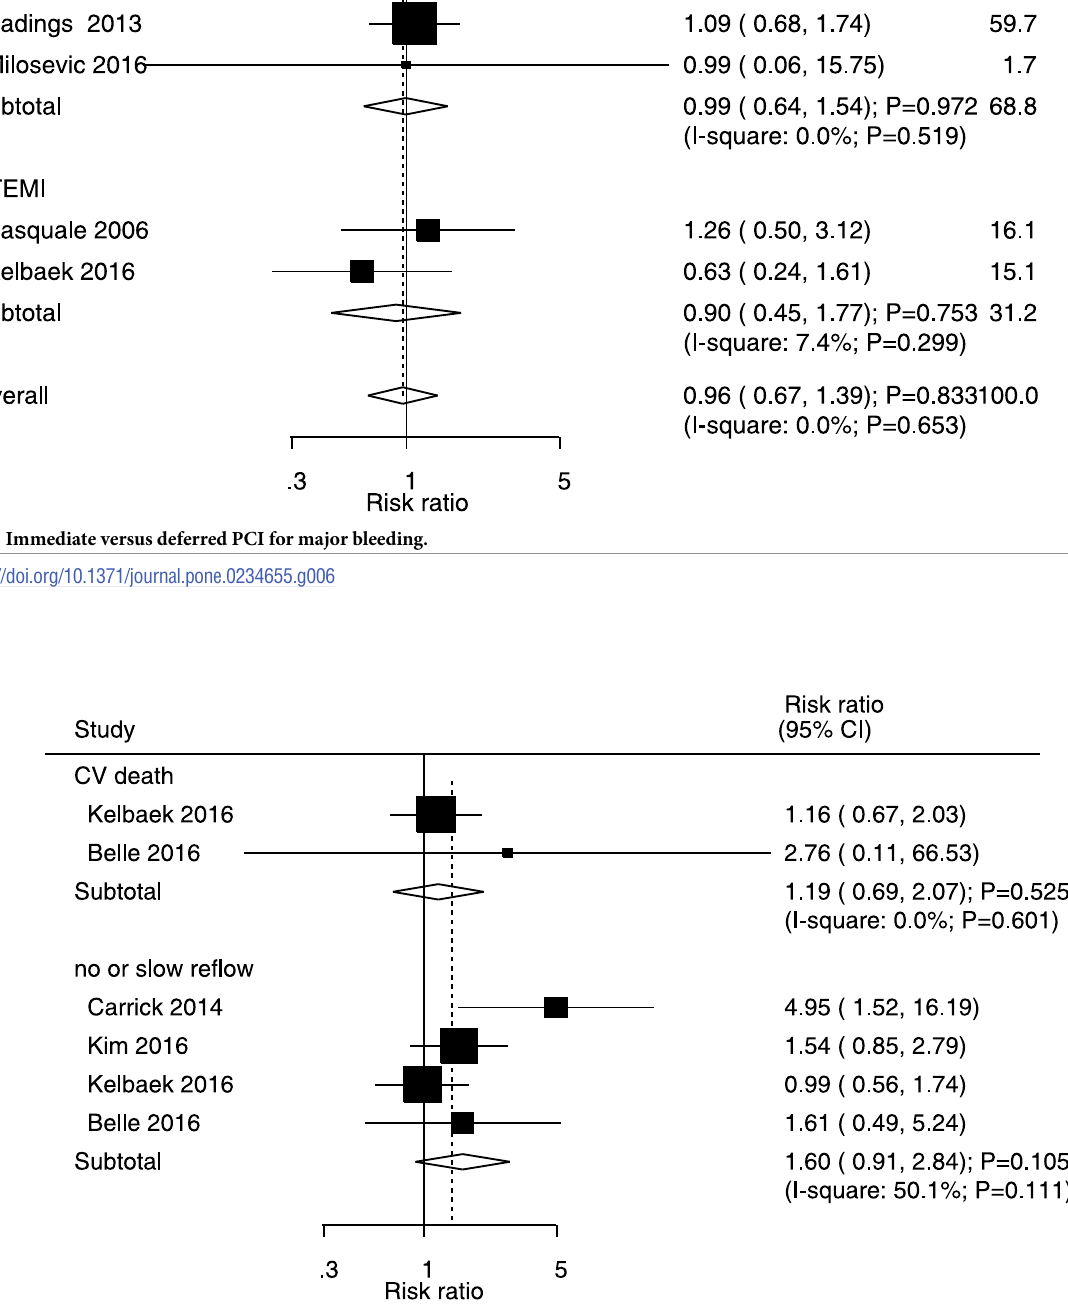
PLOS ONE | https://doi.org/10.1371/journal.pone.0234655 July 2,